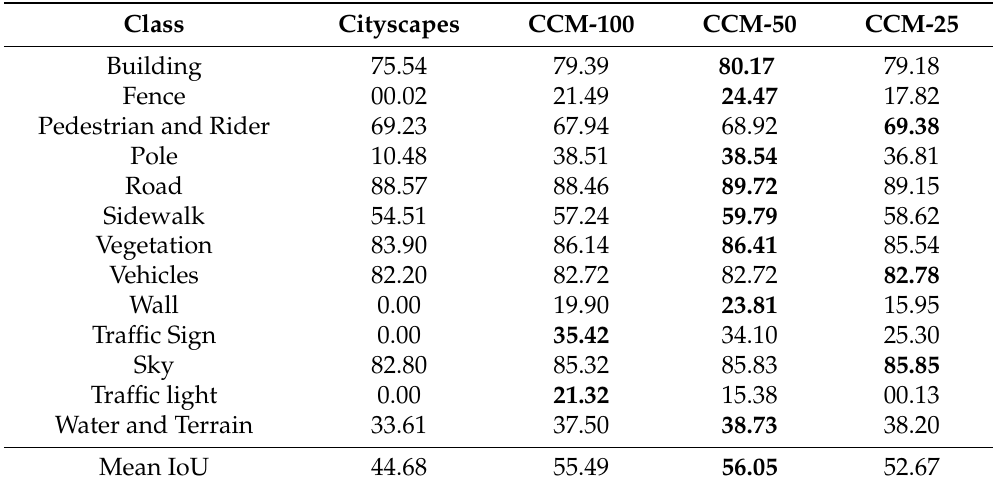
Table 5. Semantic segmentation (IoU) with MobileNetV2 on Cityscapes and CCM datasets.